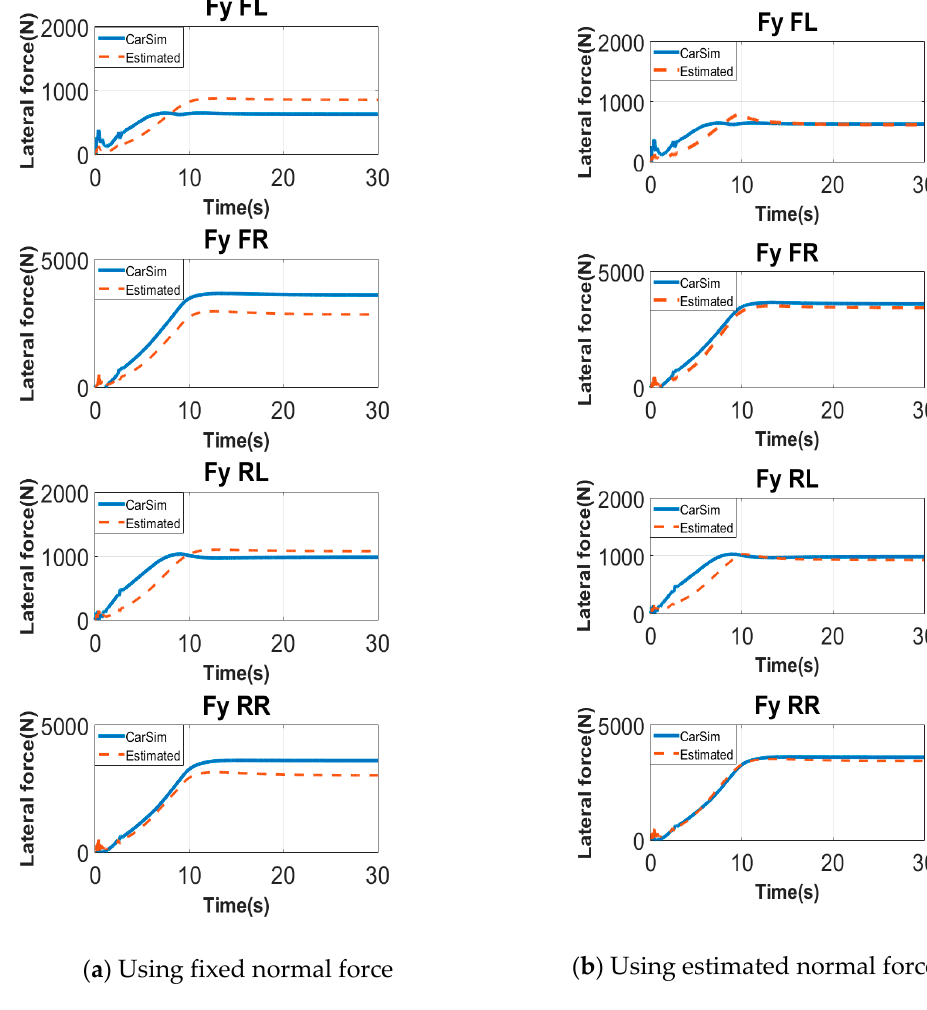
Figure 2. Simulation results of estimated lateral force.